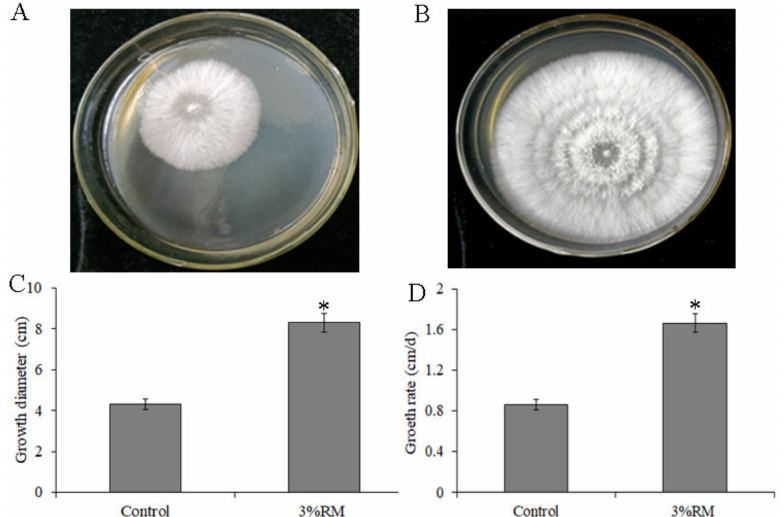
Figure 2. R . roxburghii must (RM) promoted the growth of P. ostreatus mycelia. ( A ): control group (without must); ( B ): must group (3% v / v ); ( C ): diameter of P . ostreatus mycelia cultured for 5 days on a potato dextrose agar (PDA) medium contain 3% R . roxburghii must or not; ( D ): growth rate of P . ostreatus mycelia on a PDA medium contain 3% R . roxburghii must or not. * indicates a significant difference at p < 0.05 compared with the control group.